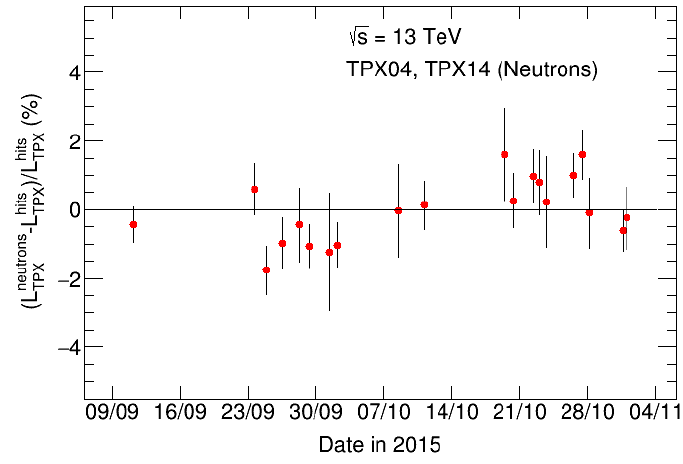
Figure 57. Evolution in time of the fractional difference in fill-integrated luminosity between the TPX neutron-counting and the TPX hit-counting reference luminosity. Each point shows the mean difference for a single LHC fill as defined in the text. The error bars are statistical only, and convoluted with 0.5% relative uncertainty from the TPX hit-counting reference measurement. The TPX neutron luminosity is normalized to the TPX hit-counting luminosity [14]. The data of the devices TPX04 and TPX14, layers 1 and 2, are combined. Taken from Ref. [17].